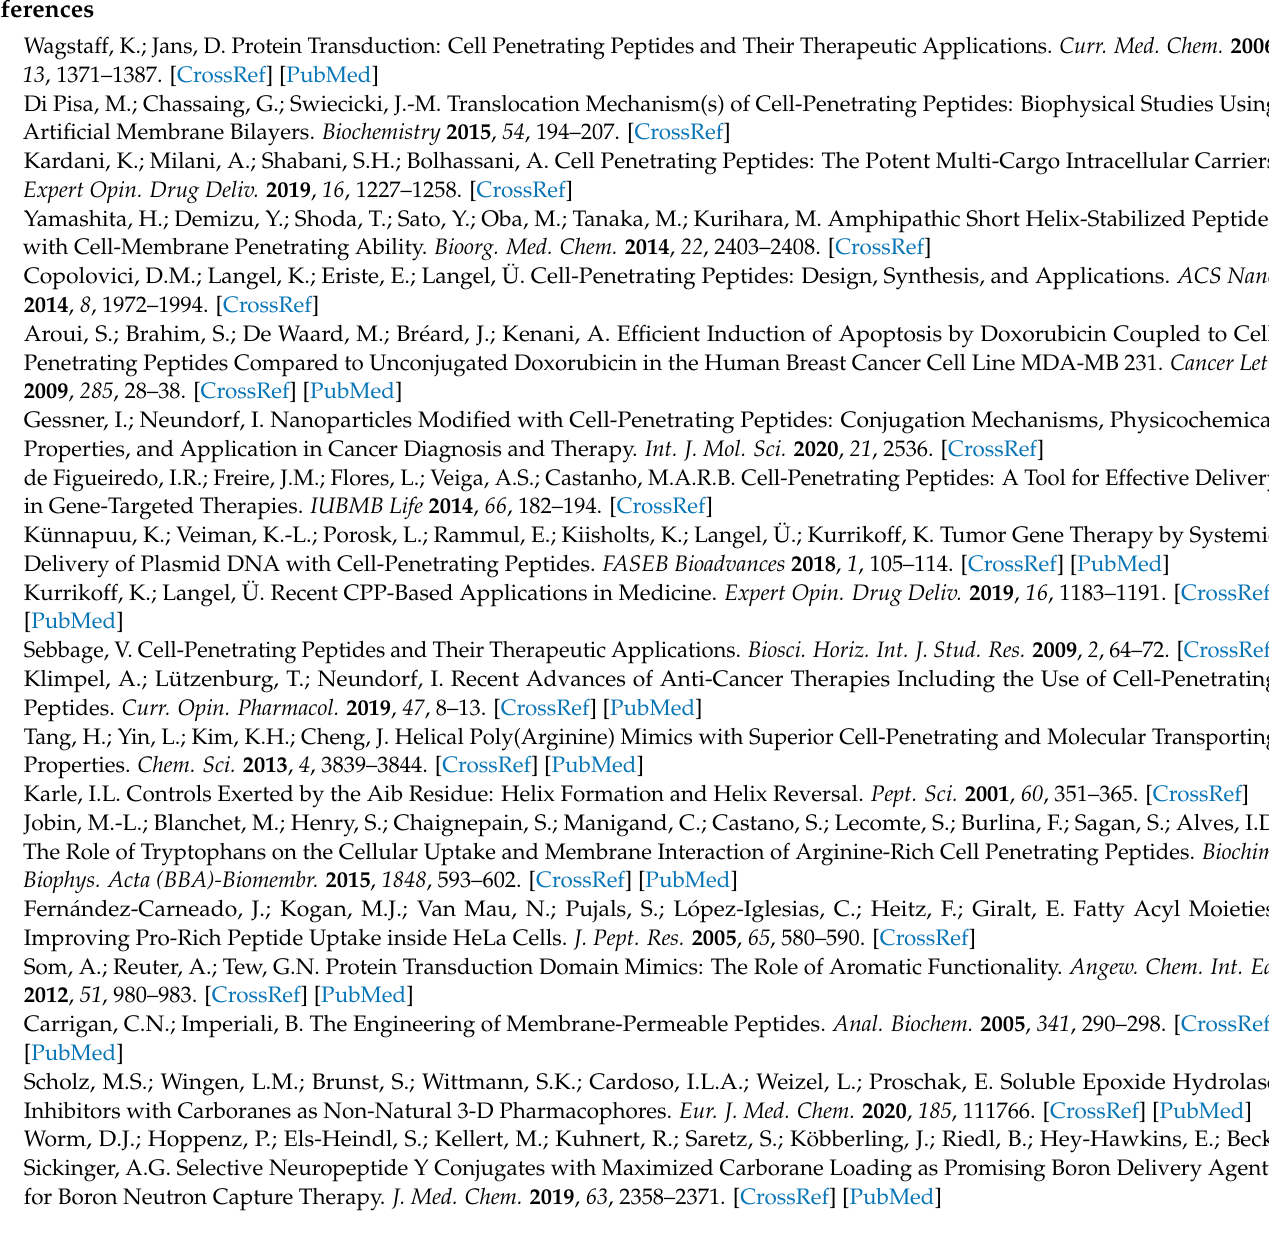
Figure S34: Electrophoretic mobility shift assay (EMSA), Figure S35: Overlay of intensity profiles, Table S1: Names, sequences, analytical data and critical micelle concentration (CMC) of the CB-sC18 series, the CF-labeled CB-sC18 series and the CB-pVEC